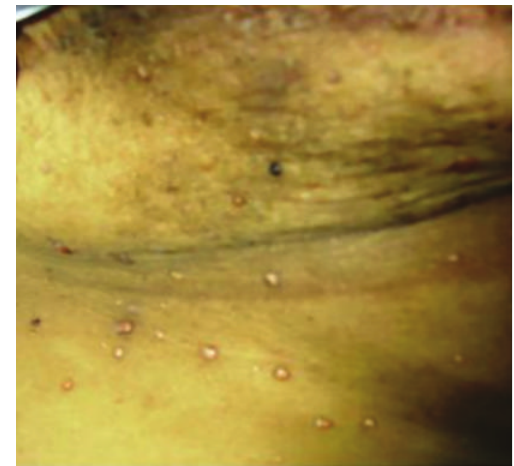
Figure 4: Papules and nodules in and around the mastectomy scar—Case